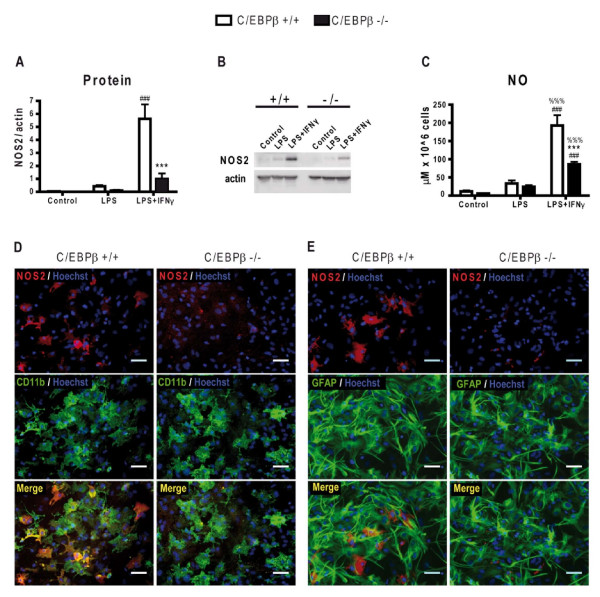
Absence of C/EBPβ dramatically decreases microglial NOS2 protein expression and NO production in activated mixed glial cultures. A. NOS2 protein levels in total protein extracts from mixed glial cultures were analyzed by western blot, followed by densitometry. Data is expressed as NOS2 versus β-actin band intensities. Cultures were treated for 16 h with LPS, LPS+IFNγ or vehicle. In C/EBPβ+/+ cultures (white bars) NOS2 protein levels were detected after LPS treatment, but LPS+IFNγ induced a clear upregulation, in agreement with mRNA expression levels. In C/EBPβ-/- mixed glial cultures (black bars), NOS2 protein levels decreased in LPS and LPS+IFNγ compared to C/EBPβ+/+ cultures. Two-way ANOVA, followed by Bonferroni's test was applied. ***p < 0.001 compared with C/EBPβ+/+ condition. ###p < 0.001 compared with respective control condition. (n = 5). A representative western blot is shown in B. C. NO production is decreased in activated C/EBPβ-/- glial cultures. NO levels were measured by colorimetric analysis 48 h after treatments and normalized per cell number. Values are reported as micromolar concentration ×106 cells. NO levels in C/EBPβ+/+ (white bars) cultures were upregulated after LPS and LPS+IFNγ treatments compared to controls. In C/EBPβ-/- glial cultures (black bars), NO production is reduced in LPS+IFNγ treatment compared to wild-type NO levels. Two-way ANOVA, followed by Bonferroni's test was applied. ***p < 0.001 compared to C/EBPβ+/+ condition. ###p < 0.001 compared to respective control condition. %%%p < 0.001 compared to respective LPS condition. (n = 7-9). D. NOS2 is expressed by activated microglia. C/EBPβ+/+ and C/EBPβ-/- secondary mixed glial cultures were immunostained for CD11b (green) and NOS2 (red), and stained for Hoechst 33258 (blue) after 16 h of LPS+IFNγ treatment. The C/EBPβ+/+ merged image shows colocalization of NOS2-positive cells and CD11b-positive cells. Bar = 50 μm.